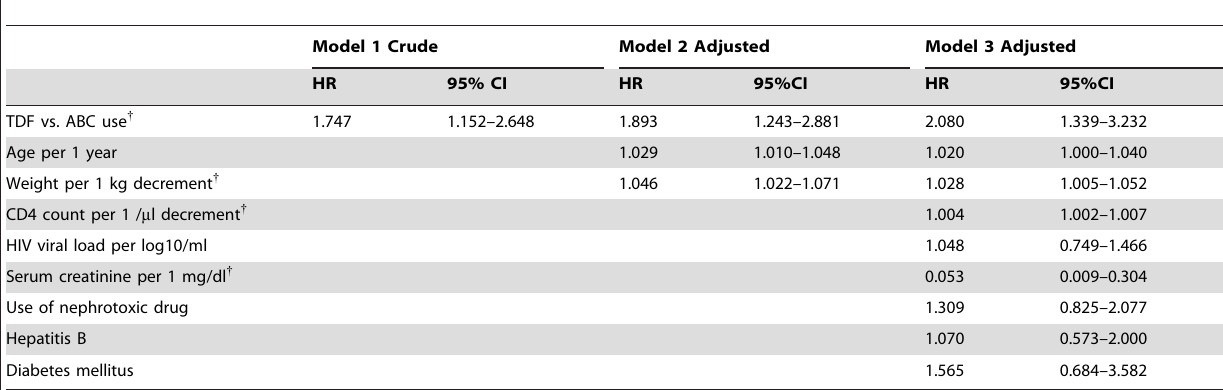
Table 3. Multivariate analysis to estimate the risk of TDF- over ABC-based antiretroviral therapy in inducing more than 25% fall in eGFR.